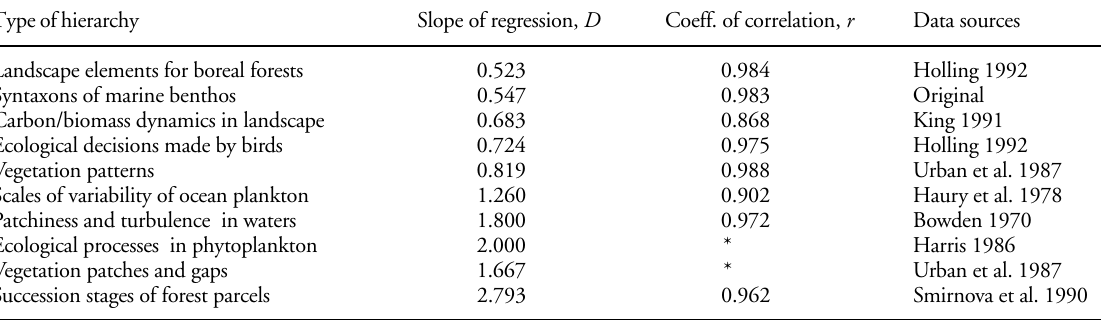
Table 1. Reciprocal scaling of temporal and spatial ranges for ecological hierarchies: [Time] = a [Space] D